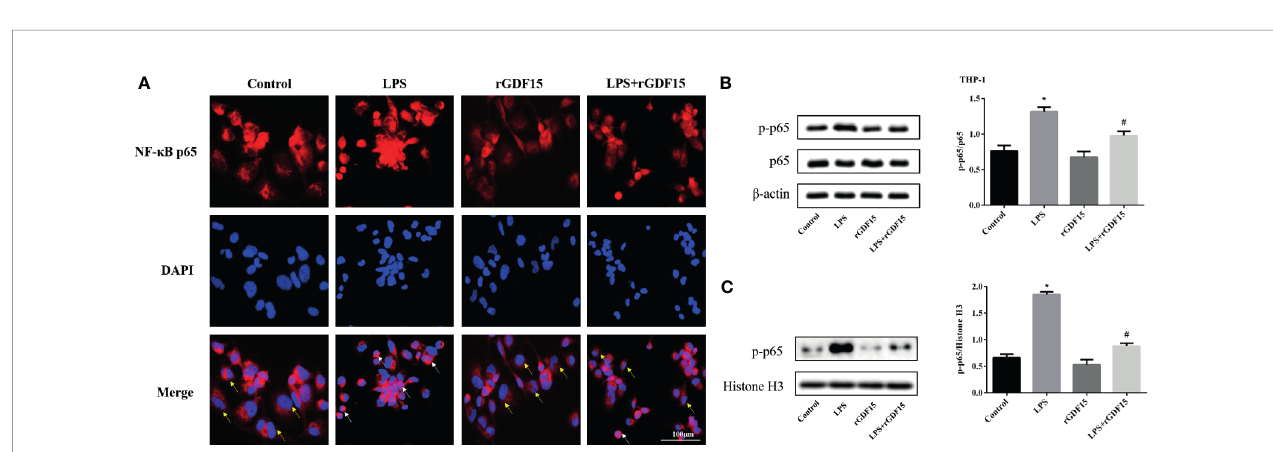
FIGURE 14 | Nuclear translocation of NF- k B p65 in THP-1 cells pretreated with rGDF15 in in fl ammatory state was detected by immuno fl uorescence (A) . Scale bar = 100 m m. Red fl uorescence marked NF- k B p65 and blue fl uorescence marked nucleus. Yellow arrows indicated nuclear translocation negative cells; white arrows indicated nuclear translocation positive cells. The NF- k B p65 phosphorylation level of THP-1 cells pretreated with rGDF15 in in fl ammatory state was detected by Western blot (B) . The expression of p-p65 in the nucleus was detected by Western blot (C) . * P < 0.05, compare with the control group; # P < 0.05, compare with the LPS